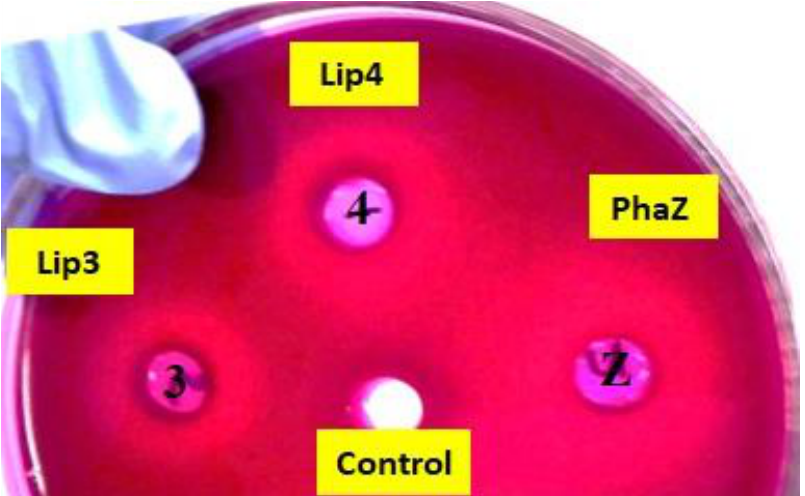
Figure 2. PHA agar plate assay for testing the depolymerase/esterase activity of LIP3, LIP4, and PhaZ. The clearance zones around the wells to which 20 µ g of purified LIP3, LIP4, and PhaZ enzymes were added show hydrolysis of mcl-PHA in rhodamine B-PHO agar plates after UV irradiation. As a control, a crude extract of the noninduced expression host E. coli BL21(DE3) was used.